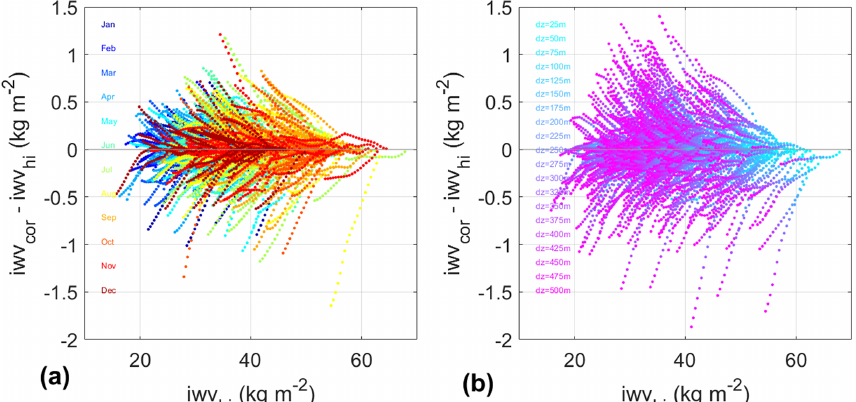
Figure 5. IWV correction error, x i, c − y i , with (a) monthly coefficients and (b) yearly coefficients, as a function of time and height difference, (cid:49)h = 25 ... 500m. Both models used polynomials of order 5 and weighted least-squares estimation. The time is colour coded in panel (a) , while the height difference is colour coded in panel (b) . The dots aligned in filaments correspond to a given time and varying (cid:49)h in both